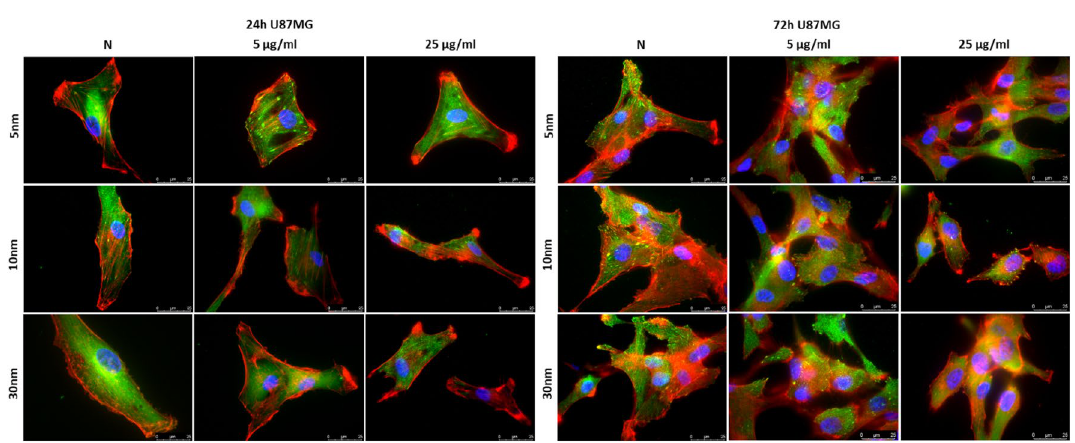
Figure 11. Cytoskeleton architecture of U87MG cells after 24 and 72-h long of exposure to IONPs with 5 nm, 10 nm and 30 nm core diameters in concentrations of 5 µg Fe/ml and 25 µg Fe/ml compared with control groups (N). The F-actin filaments are stained on red colour, vinculin on green and DNA on